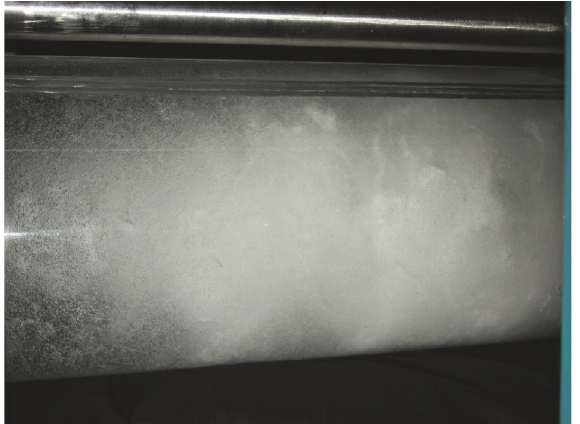
Figure 67: Lady 21